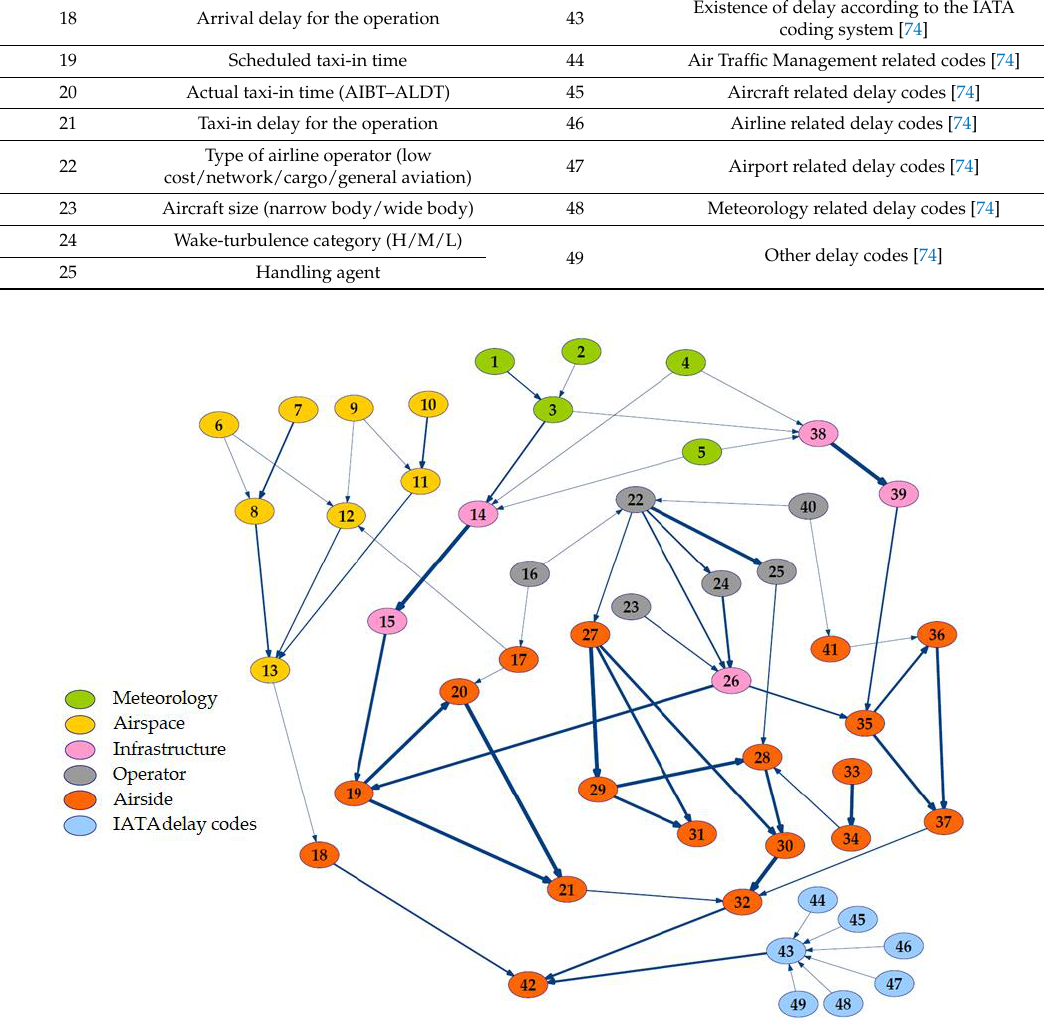
Figure 14. BN model to understand the interdependencies between factors that influence delay performance and system saturation. Colours represent different BN layers.